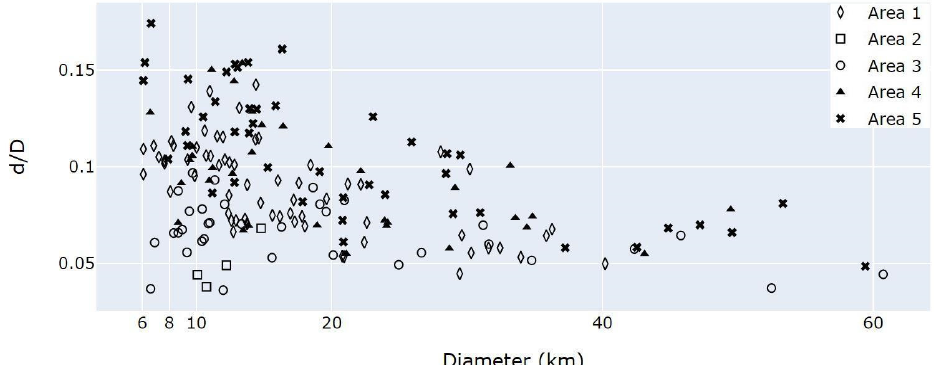
Figure 8. d/D ratio vs Diameter plot of freshest craters only. Note that Area 2 and Area 3 terrains are predominant at the bottom of the plot.